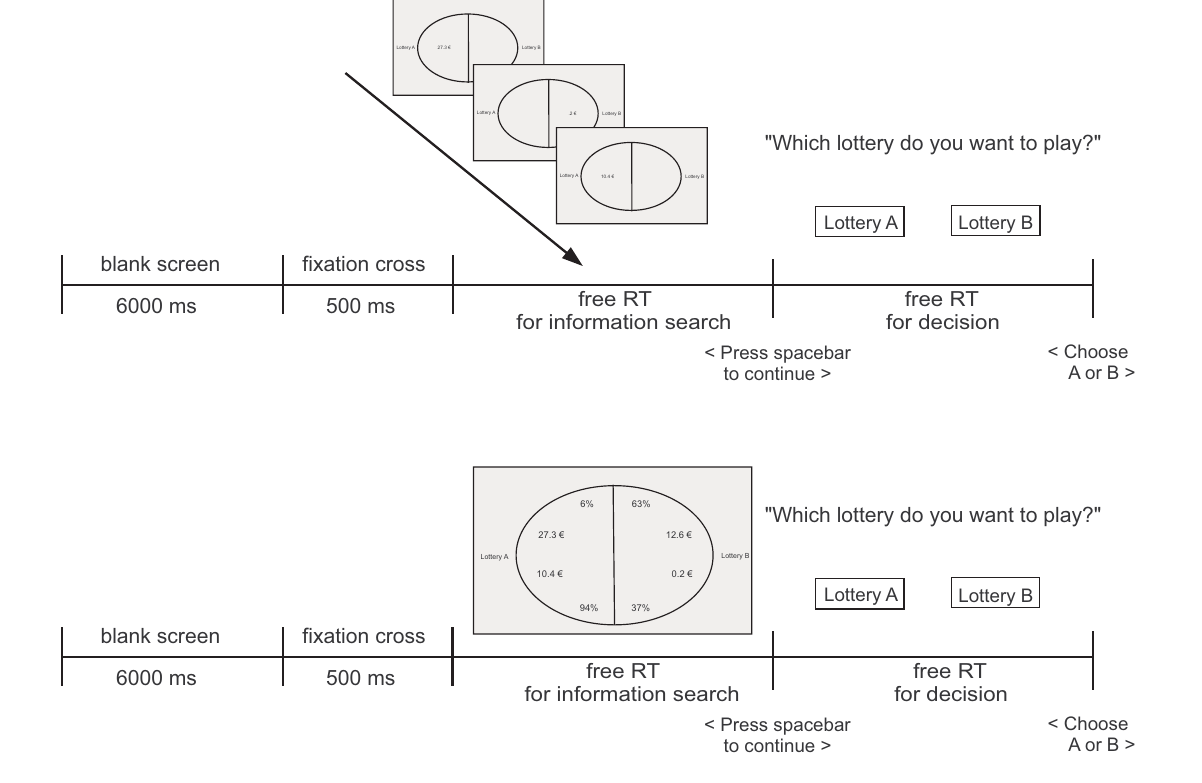
FIGURE 1 | Procedure in the experience (top panel) and the description (bottom panel) condition. Note. RT means response